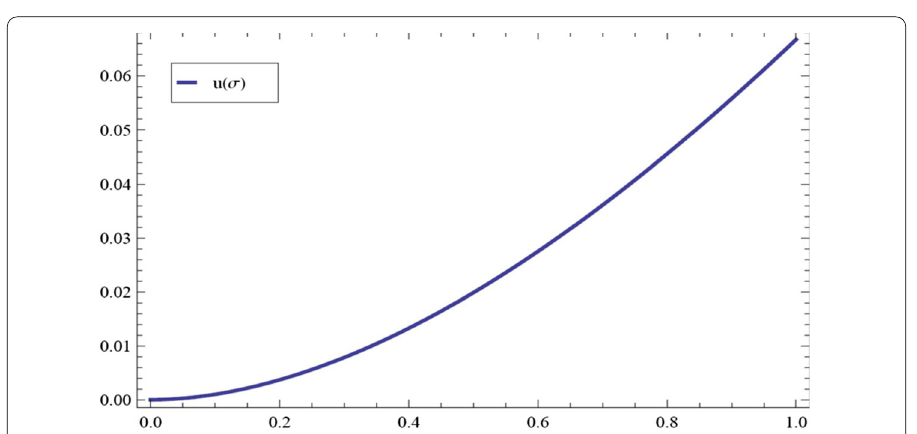
Figure 2 The solution u ( σ ) of (22) with the initial condition u (0) = u (cid:4) (0) = 0